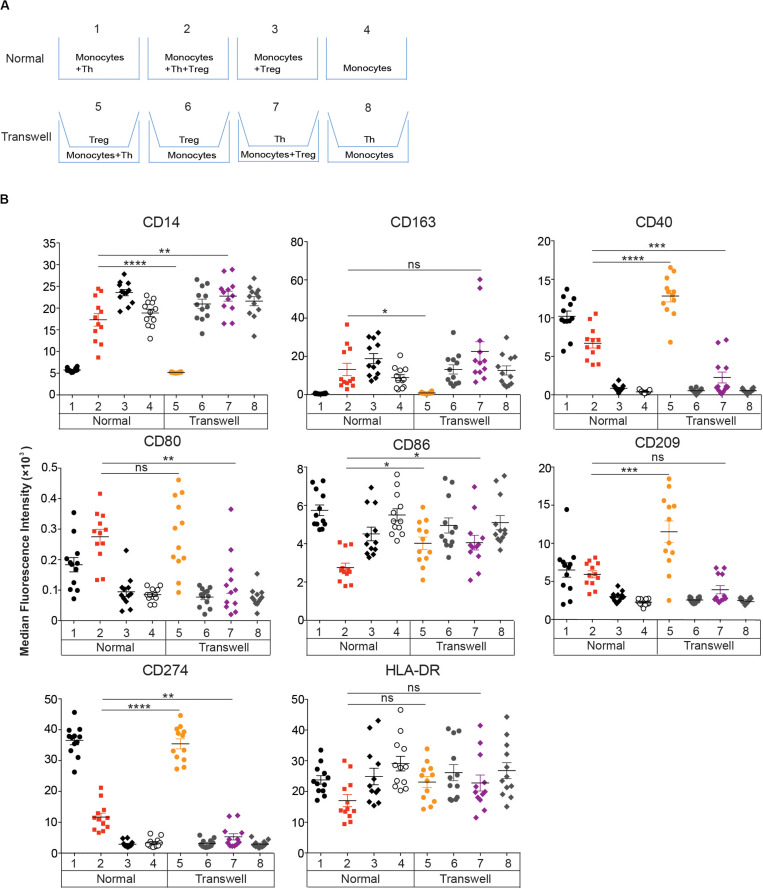
Effect of Tregs on DCReg differentiation requires cell-cell contact. (A,B) CD14+ monocytes were cultured for 4 days with Tregs or memory Th alone, or with Tregs and Th together at a 1:1 ratio as in Figure 2. (A) Standard and transwell cocultures were performed as described in section “Materials and Methods.” (B) MFIs of DC-associated molecules are shown after excluding CD2+HLA-DR– T cells. Mean ± SEM of 12 donors. Data are representative of 3 independent experiments. *P < 0.05, **P < 0.01, ***P < 0.001, ****P < 0.0001, ns, not significant. Data were analyzed with unpaired T-test.